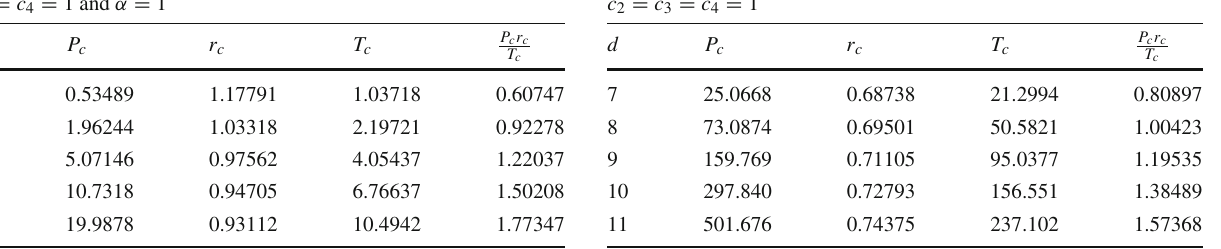
Table 5 Ricci flat black holes: k = 0, q = 1, m = 1 and c 0 = c 1 =